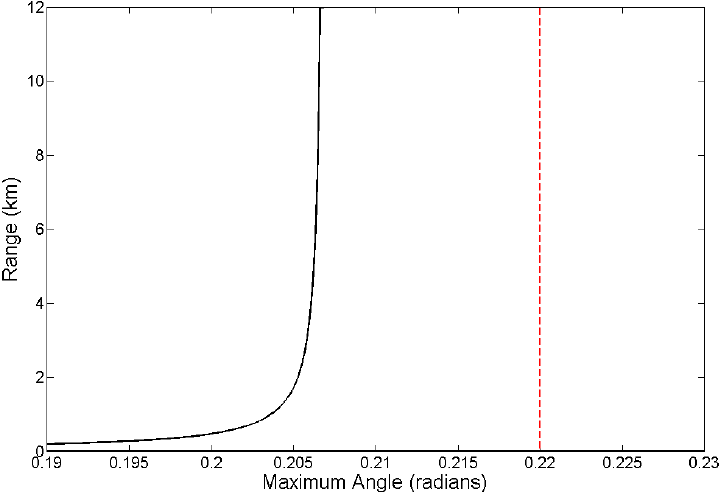
Figure 3. The maximum ray angle at the optical fiber as a function of range. The fiber numerical aperture requires angles less than 0.22 radians for efficient coupling. The vertical red dashed line indicated the maximum ray angle accepted by the optical fiber.